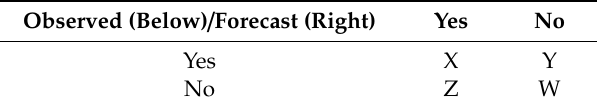
Table 1. The template for signal detection